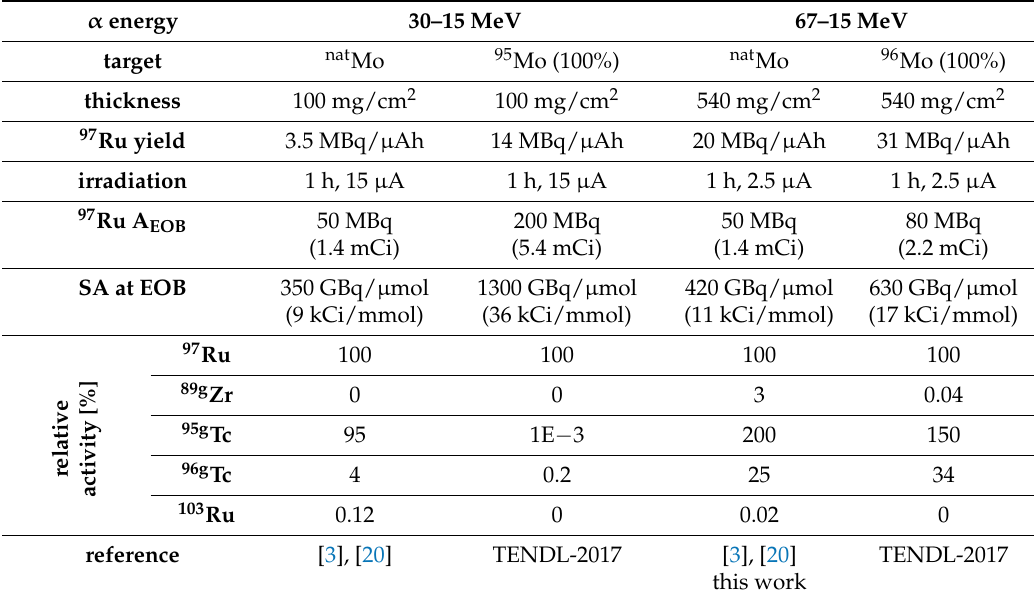
Table 3. Estimation of 97 Ru activity produced via the irradiation of nat Mo (based on experimental data) and enriched 95,96 Mo targets (based on TENDL-2017 [29]) with α beam in two energy ranges. The list of radioactive impurities is narrowed down to the long-lived ones and shows their activity relative to activity of 97 Ru at